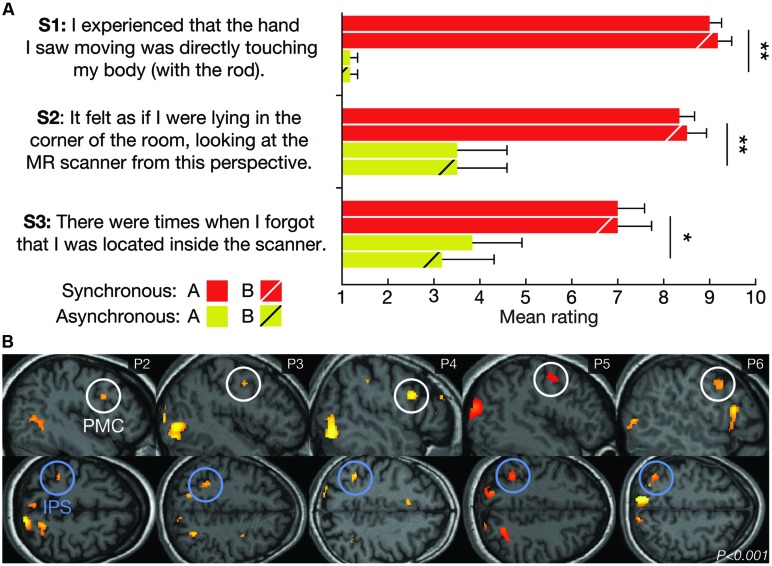
Subjective and neurophysiological evidence for successful illusion induction. (A) The average subjective ratings of questionnaire statements S1–S3 for LOCATION A and LOCATION B during the SYNCHRONOUS and ASYNCHRONOUS conditions, respectively. The SYNCHRONOUS condition generated significantly higher ratings for the illusion statements (S1–S3), compared with the ASYNCHRONOUS condition. There was no significant difference in the illusion strength between LOCATION A and LOCATION B. The error bars represent the SEM, and the statistical results refer to the main effect of the visuo-tactile stimulation mode in a 2 × 2 analysis of variance (ANOVA). *P < 0.05, **P < 0.01. (B) Examining the main effect of the visuo-tactile stimulation mode using standard univariate analysis revealed increased activity in key multisensory regions in five out of six participants (P2–P6) at the statistical threshold of P < 0.001 (uncorrected). One representative brain slice for each subject is shown for the activations in the premotor (PMC, white circles) and intraparietal cortices (IPS, blue circles), which have previously been associated with limb (Ehrsson et al., 2004) and full-body ownership (Petkova et al., 2011; Guterstam et al., 2015b).